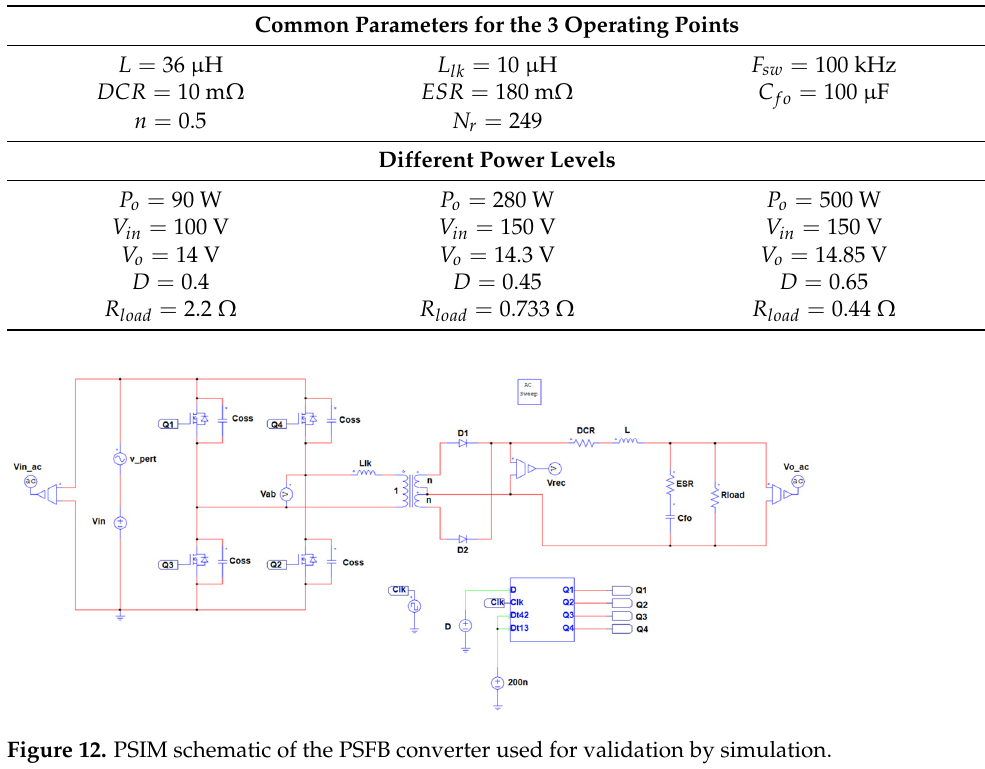
Figure 12. PSIM schematic of the PSFB converter used for validation by